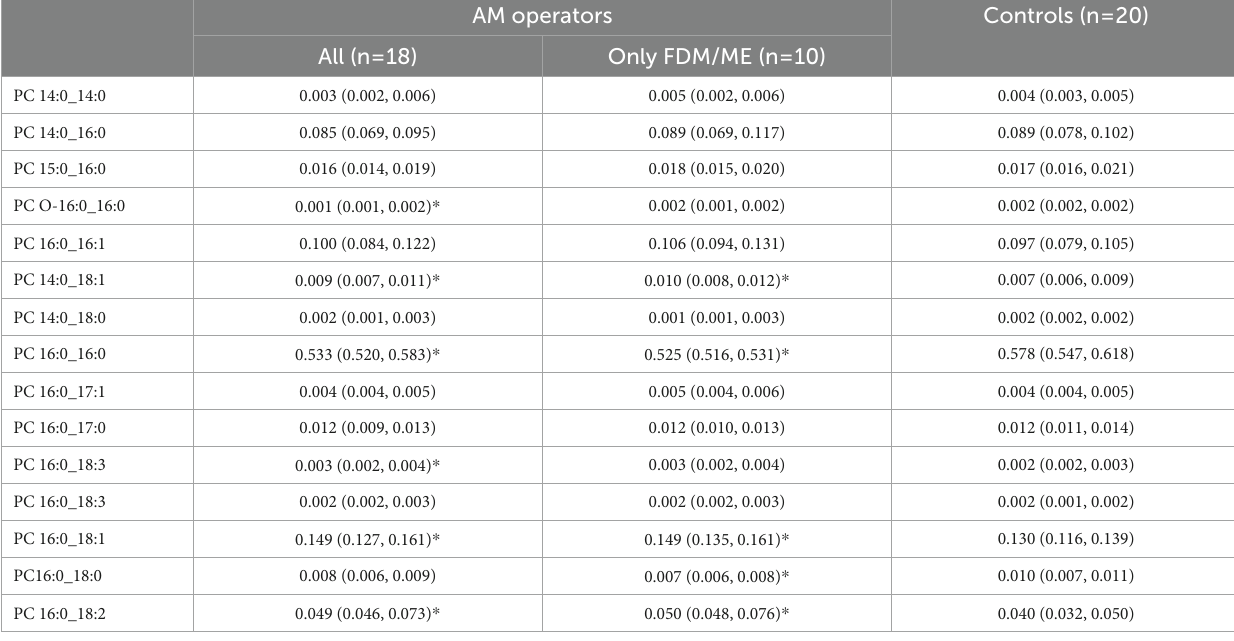
TABLE 3 Medians and interquartile range (25–75%) of PCs in exhaled particles.